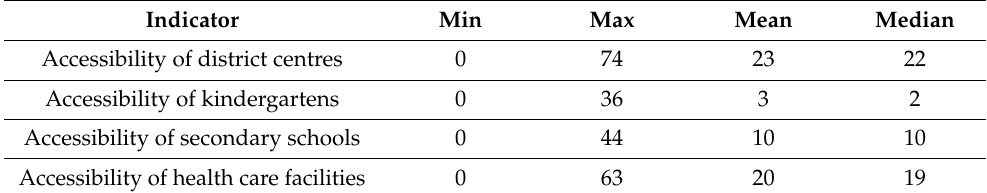
Table 3. Geographical accessibility of individual facilities and services [rounded